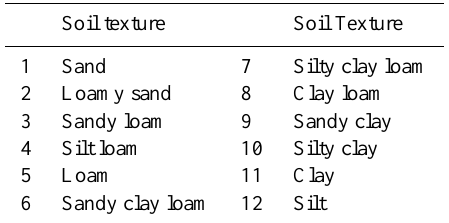
Table 1. Soil texture classification following USDA